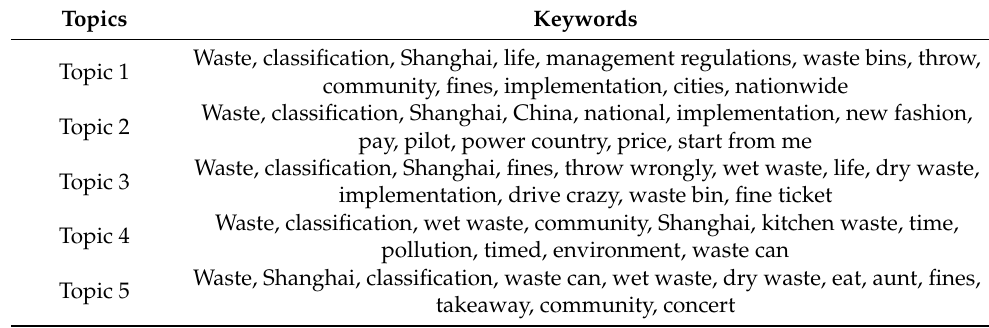
Table 5. Topics and keywords of posts from August 2019 to December